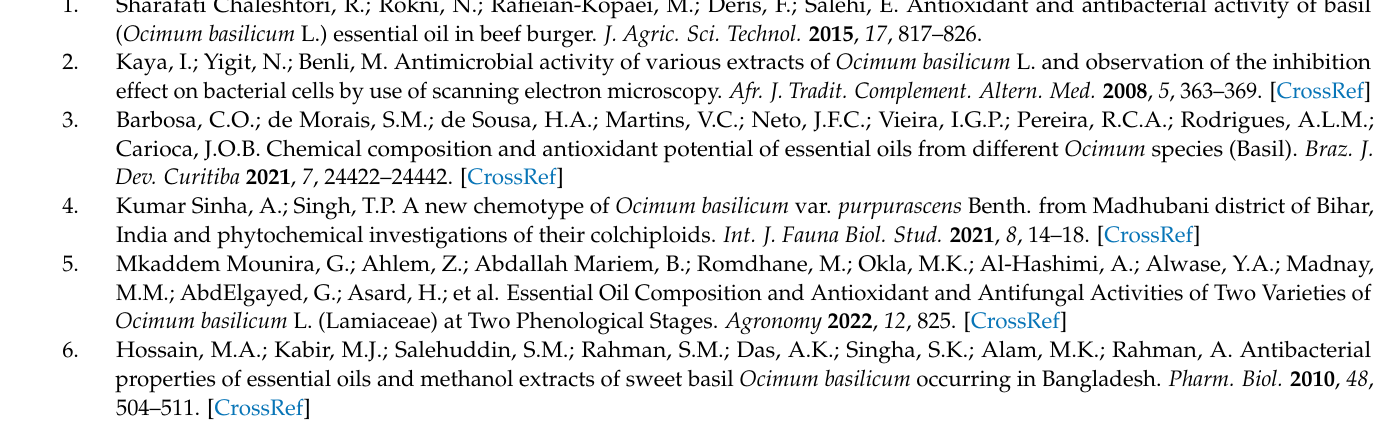
Figure S2. Kinetics during contact time of control samples with E. coli ; S. aureus ; and S. Typhimurium ; Supplement Table S1. Regression coefficients for time-kill kinetics study of control samples with E. coli ; S. aureus ; and S. Typhimurium ; Supplement Table S2. The ‘goodness of fit’ tests for prediction models of control